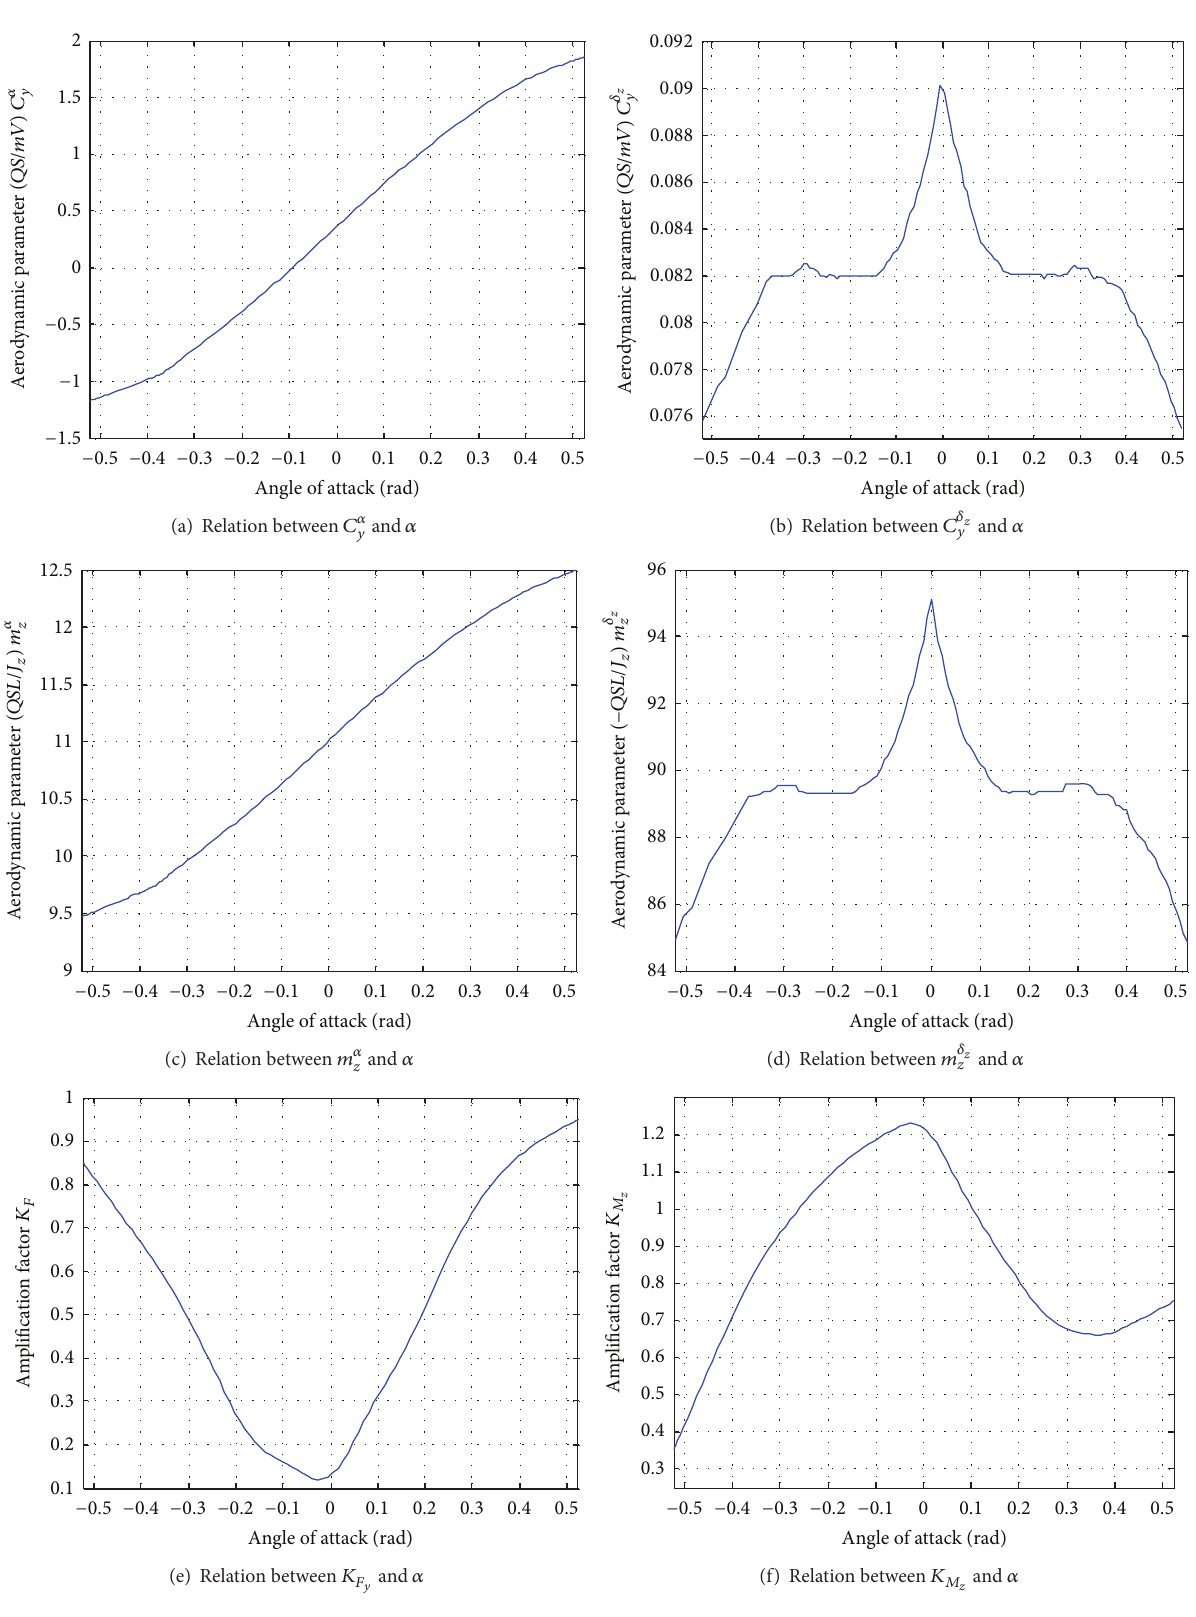
Figure 5: Aerodynamic parameters as functions of angle of